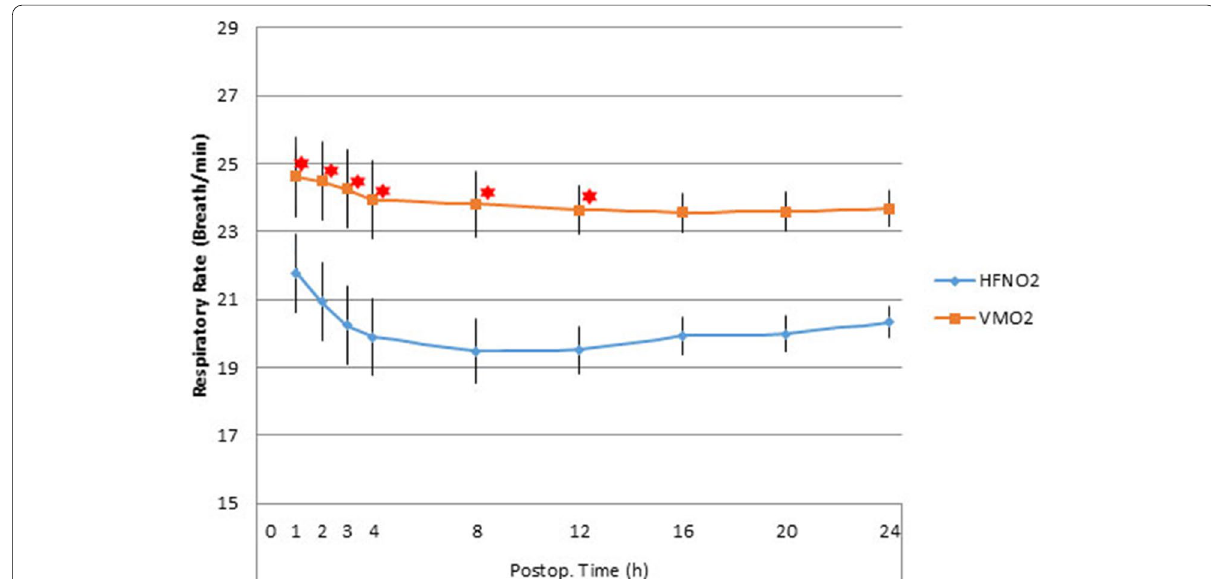
Fig. 5 The respiratory rate is significantly lower in the HFNO 2 group. The ICU stay is statistically signi. The red marks mean that the p -value was found to be